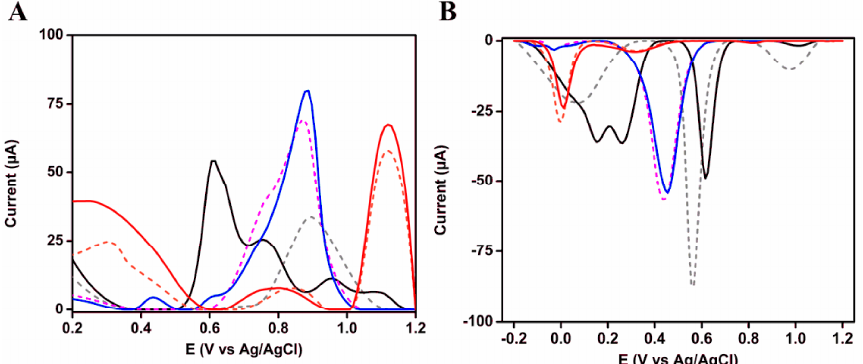
Figure 5. DPVs in ( A ) oxidation and ( B ) reduction of 50 µM VAN and the blank solutions at CA–AuNS–G–SPE at pH 1 (black and dotted grey), pH 7 (blue and dotted pink) and pH 12 (red and dotted orange).